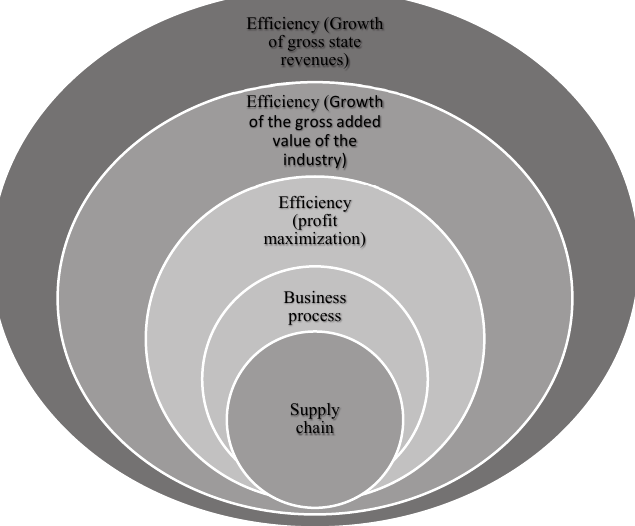
Fig. 1 . The “enlargement” of the scale of the supply chains concept from micro to macroeconomic